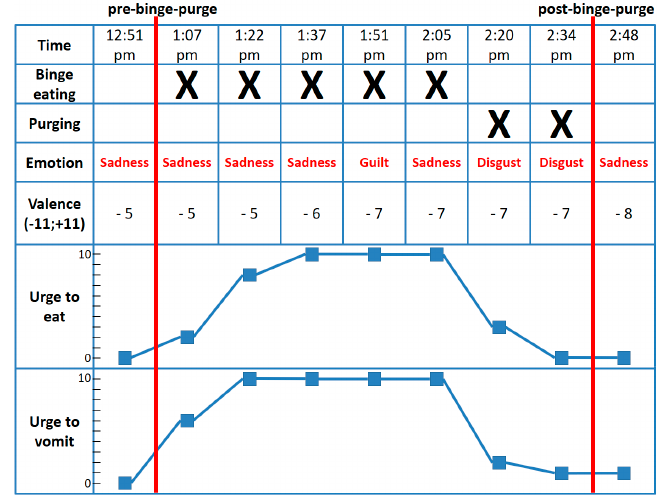
Figure 2. Affective dynamics, eating behavior, and purging behavior of a single patient with bulimia nervosa (BN) before, during, and after a binge-purge episode. Valence constitutes the intensity of emotions rated on a 11-point Likert scale from 0–11, whereas the intensity rating was multiplied by − 1 in the case of negative emotions; therefore, valence scores range from − 11 to +11. Urge to eat and urge to vomit were assessed on a 11-point Likert scale from 0–10, with higher values indicating a stronger